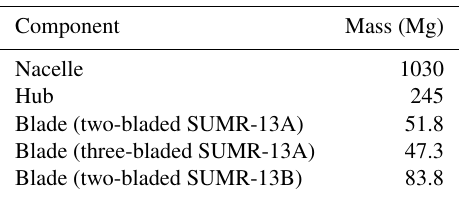
Table 6. Component masses for placing the nacelle center of mass atop the